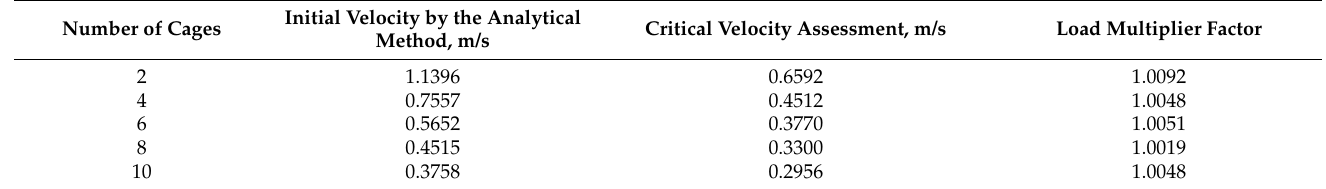
Table 11. The effect of the number of cages on the critical velocity, for the Holding State.